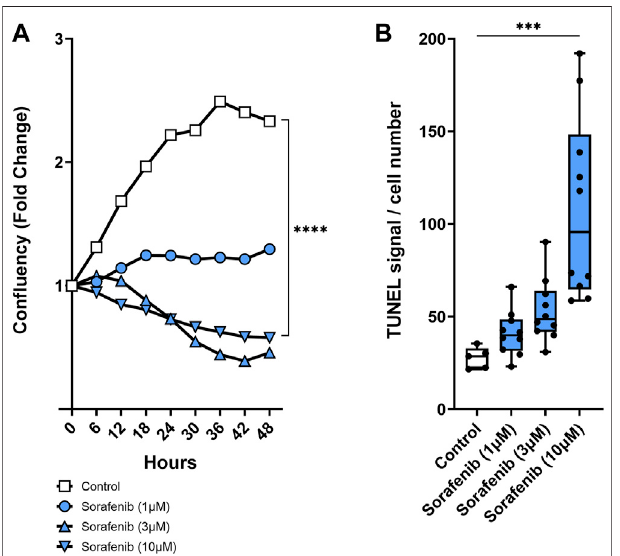
FIGURE 6 | Mesangial cytotoxicity. Sorafenib was cytotoxic to cultured mesangial cells. Sample time – course graph showing decrease in mesangial cell con fl uency with sorafenib treatment (A) . Sorafenib resulted in a dose- dependent increase in mesangial cell apoptosis (B) . n (cid:1) 5 – 10. Dots represent the average of duplicate measures for each well. *** p ≤ 0.001, **** p ≤ 0.0001 determined by ANOVA followed by the Tukey post-hoc test. Data are reported as a connected scatterplot and a box and whisker plot with median, minimum to maximum, and 10 to 90 percentiles.